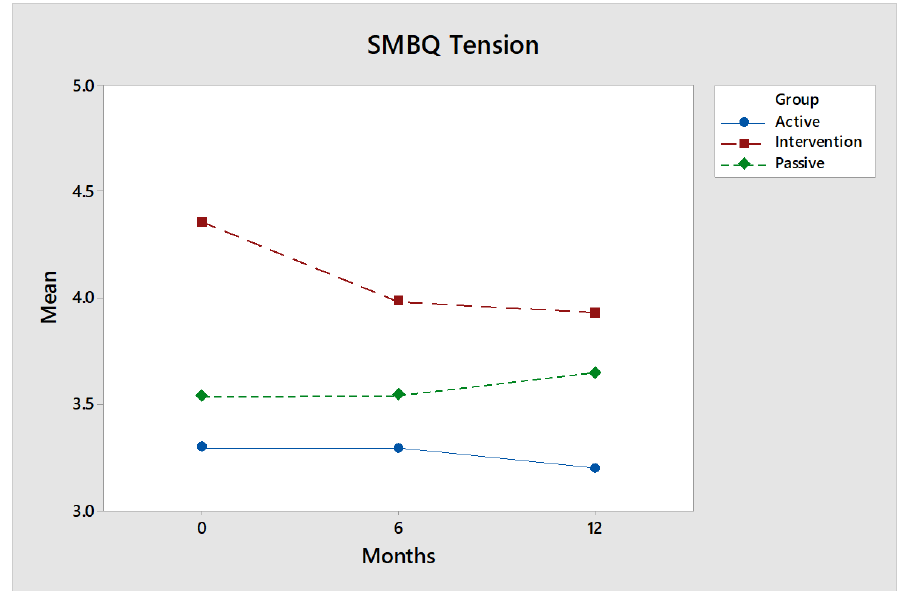
12-month follow-up.